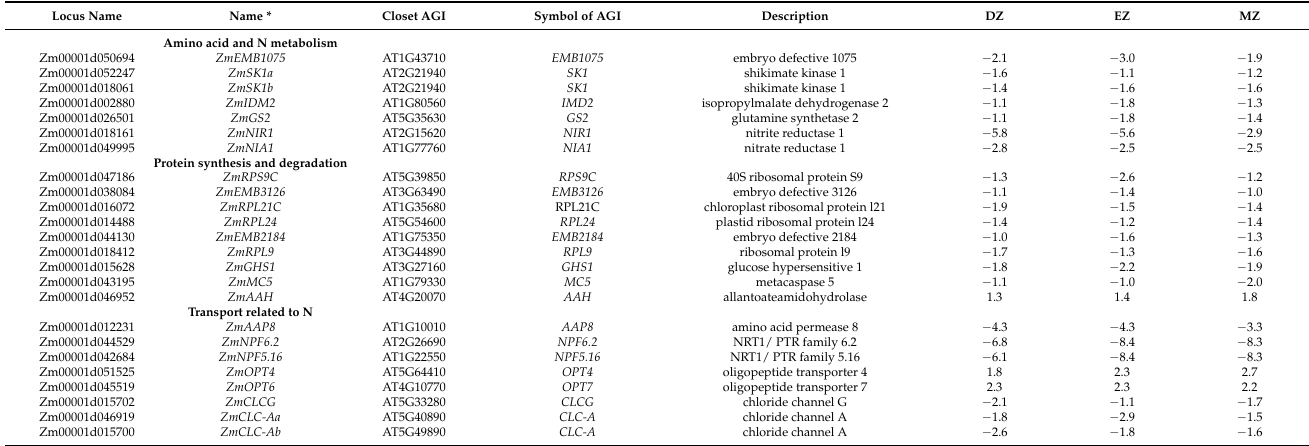
Table 1. Genes involved in N-relative pathways in the common genes.